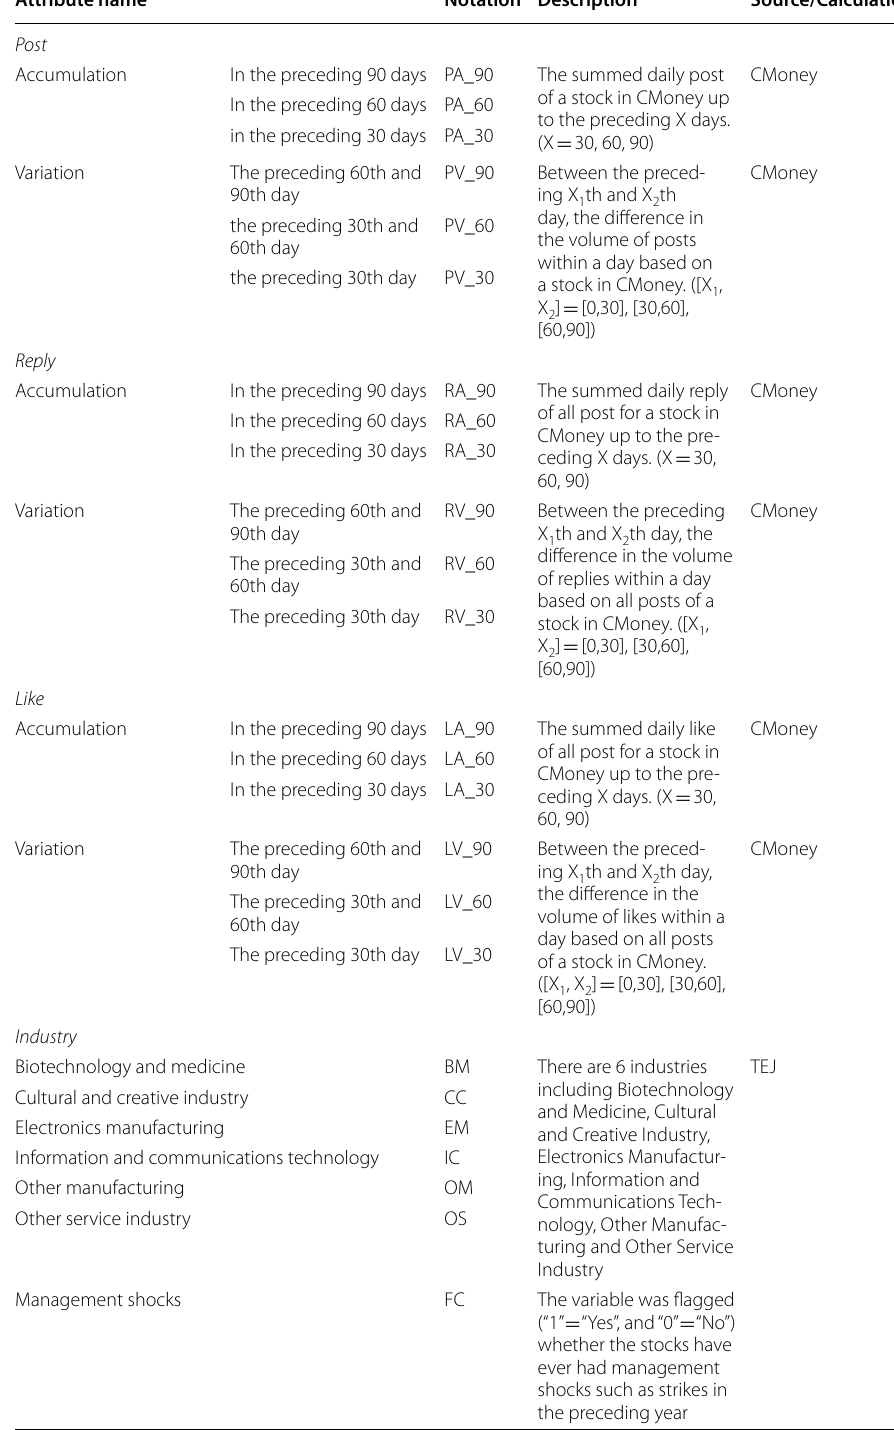
Table 2 Variable